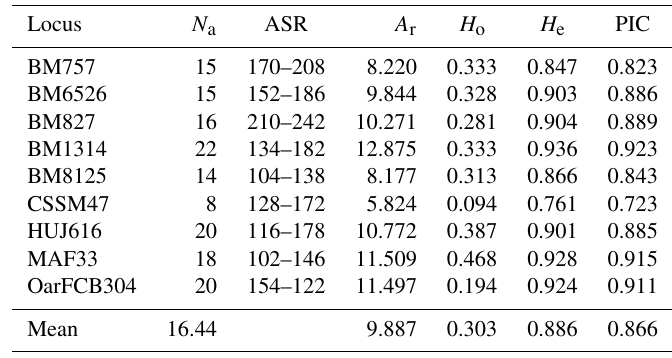
Table 2. The genetic diversity parameters for all studied loci.